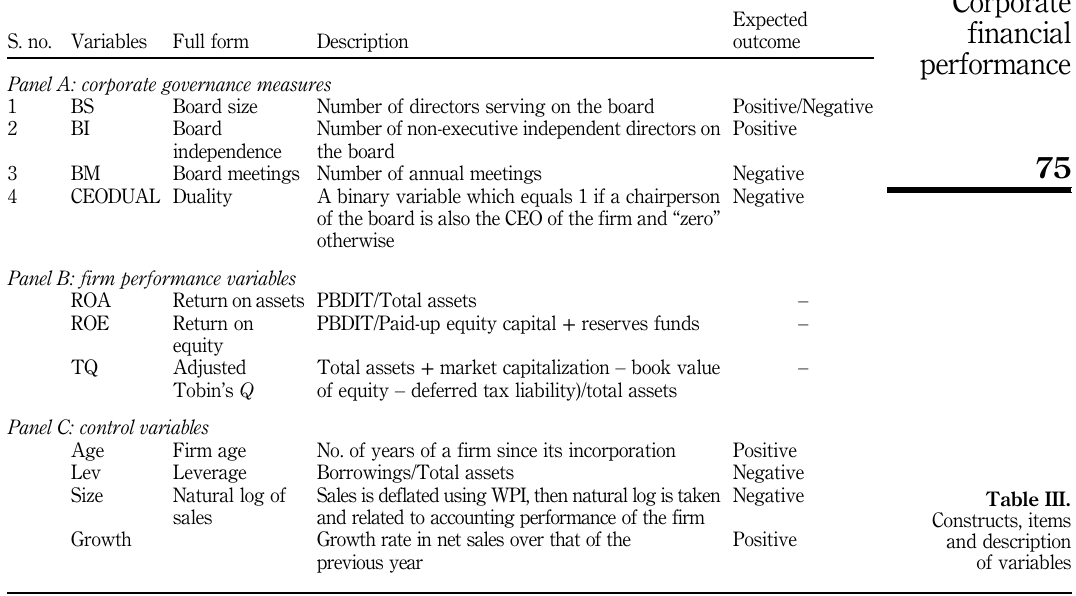
Table III. Constructs, items